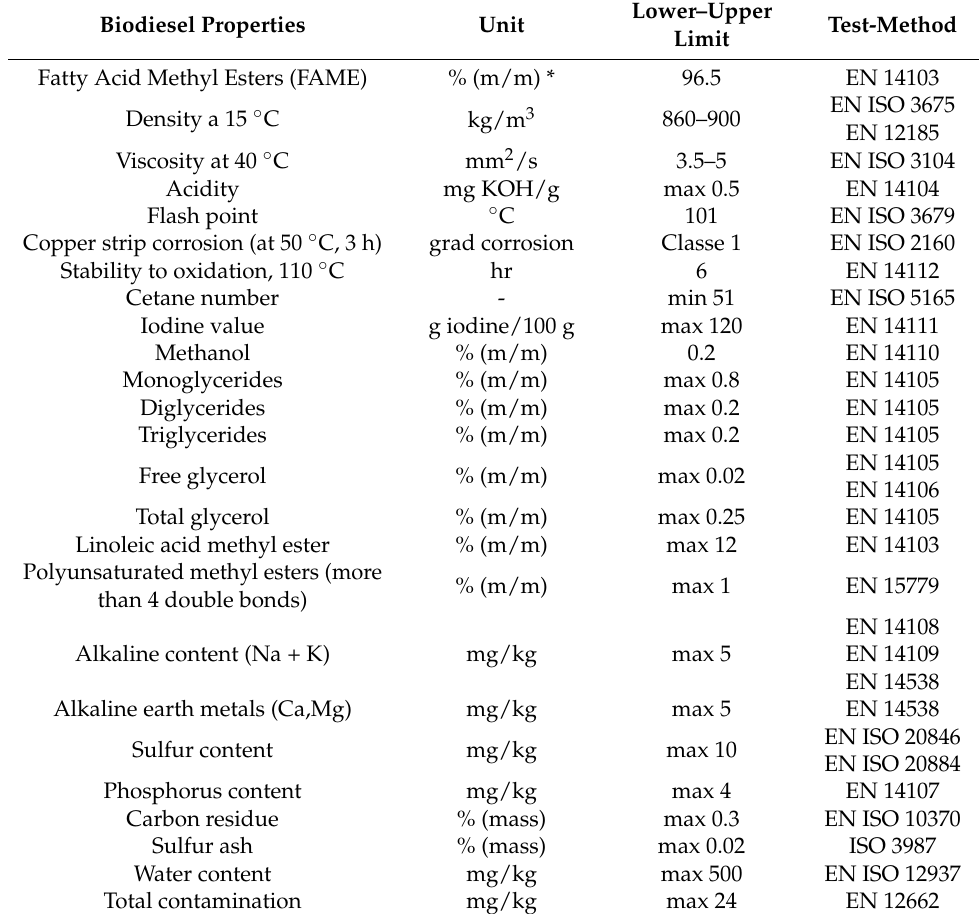
Table 1. Biodiesel characterization